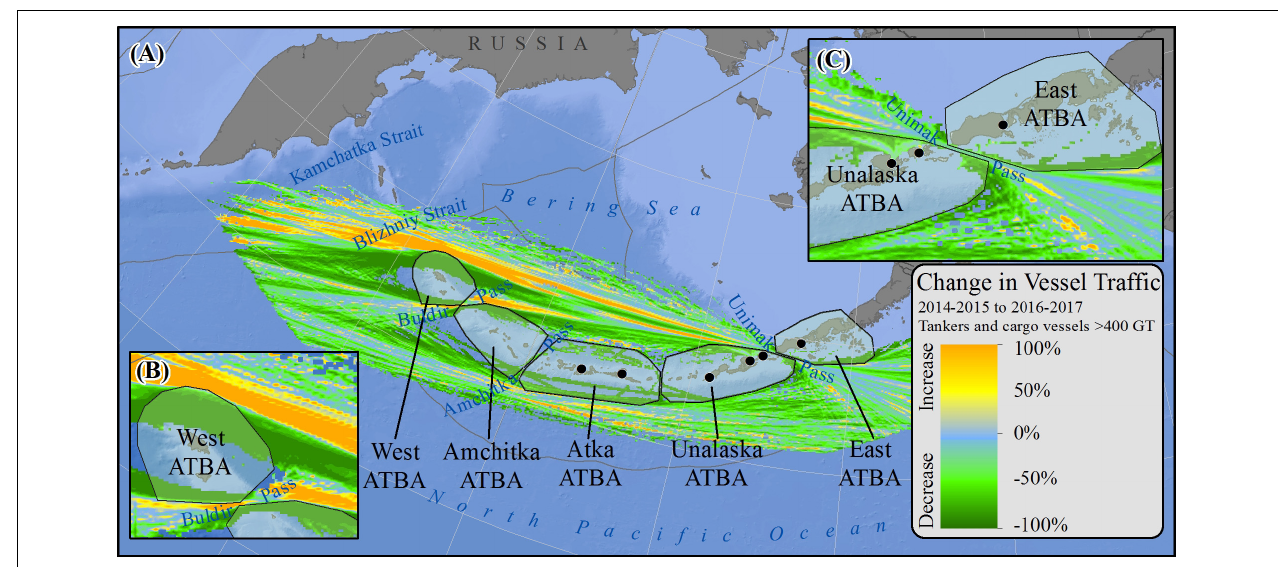
FIGURE 5 | (A) Changes in vessel traffic along the North Pacific Great Circle Route before (2014–2015) and after (2016–2017) implementation of Areas To Be Avoided (ATBAs). Only vessels subject to ATBA regulations (tankers and cargo vessels > 400 gross tons) included. Increases in vessel traffic are represented on a blue-orange gradient, and decreases in vessel traffic are represented on a blue–green gradient. (B) Detail of changes in vessel traffic near Buldir Pass, Attu Island, and the West ATBA. (C) Detail of changes in vessel traffic near Unimak Pass, Unalaska and Unimak Islands, and Unalaska and East ATBAs. TABLE 1 | Overall vessel traffic changes, pre- and post-implementation of Aleutian Areas To Be Avoided (ATBAs). Area To Be Avoided Number of vessels Number of